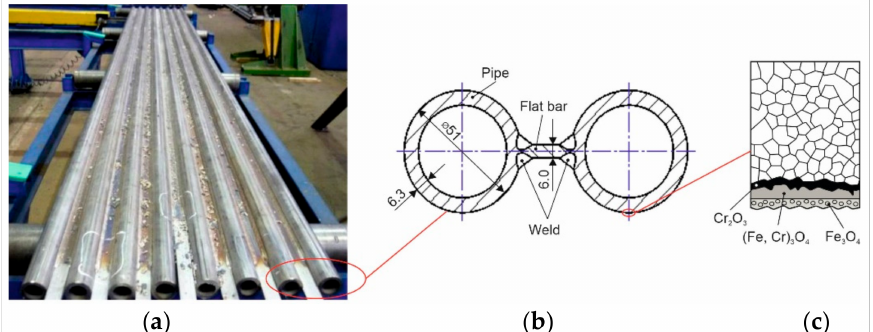
Figure 1. View of the gas-tight wall of a power boiler: ( a ) view of the panel before the surface protection process, ( b ) spectacle joint, ( c ) diagram of the formation of oxides on the surface of fine-grained austenitic steel at elevated